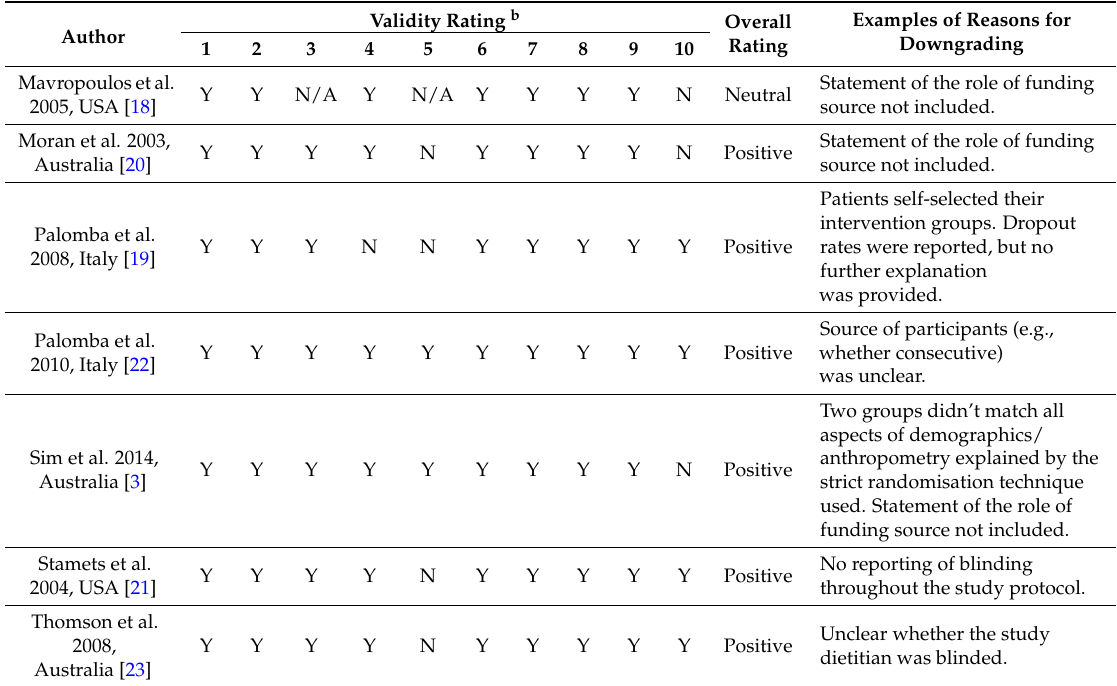
Table 2. Quality assessment of included studies a